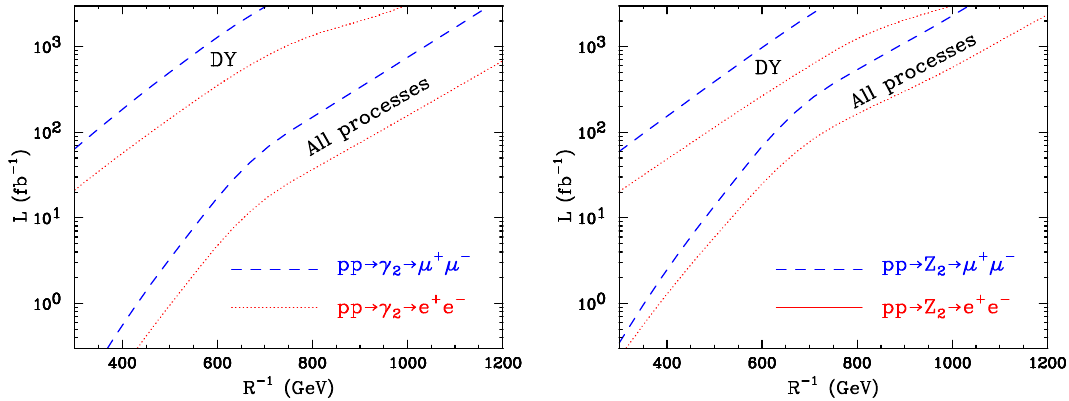
Figure 18 . 5 (cid:27) discovery reach for (cid:13) 2 (left) and Z 2 (right). We show the total integrated luminosity L (in fb (cid:0) 1 ) required for a 5 (cid:27) excess of signal over SM backgrounds in the di-electron (red, dotted) and di-muon (blue, dashed) channels. In each plot, the upper set of curves labeled as ‘DY’ make use of the single production of (cid:13) 2 or Z 2 (from (cid:12)gure 16), while the lower set of curves labeled as ‘All processes’ includes indirect (cid:13) 2 and Z 2 productions from n = 2 KK quarks (see (cid:12)gure 17). We assumed the same signal and background e(cid:14)ciencies used in ref. [21] and combined with our updated cross sections and branching